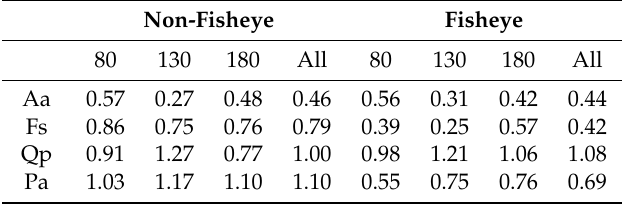
Table 1. RMSE (root mean square error) of perimeter estimation (cm) (Aa: Abies alba